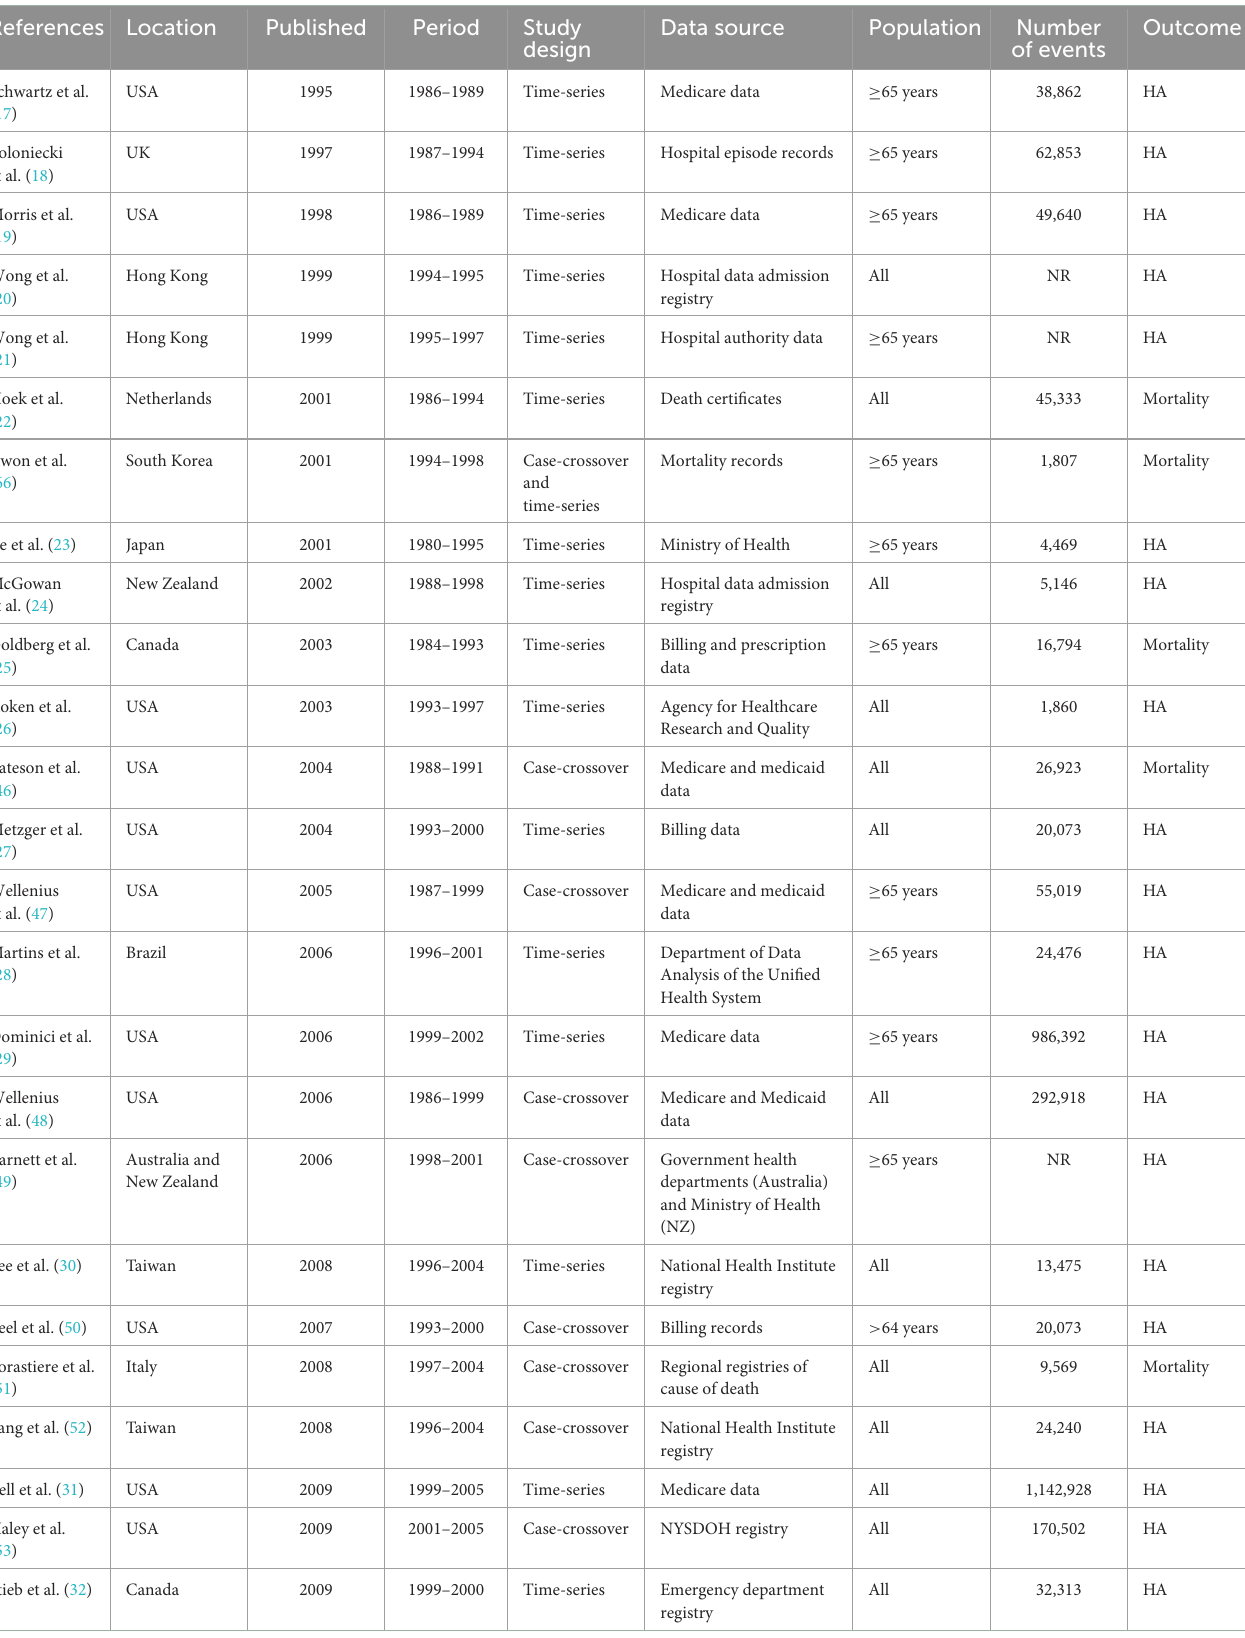
TABLE 1 Contextual details of studies included in the